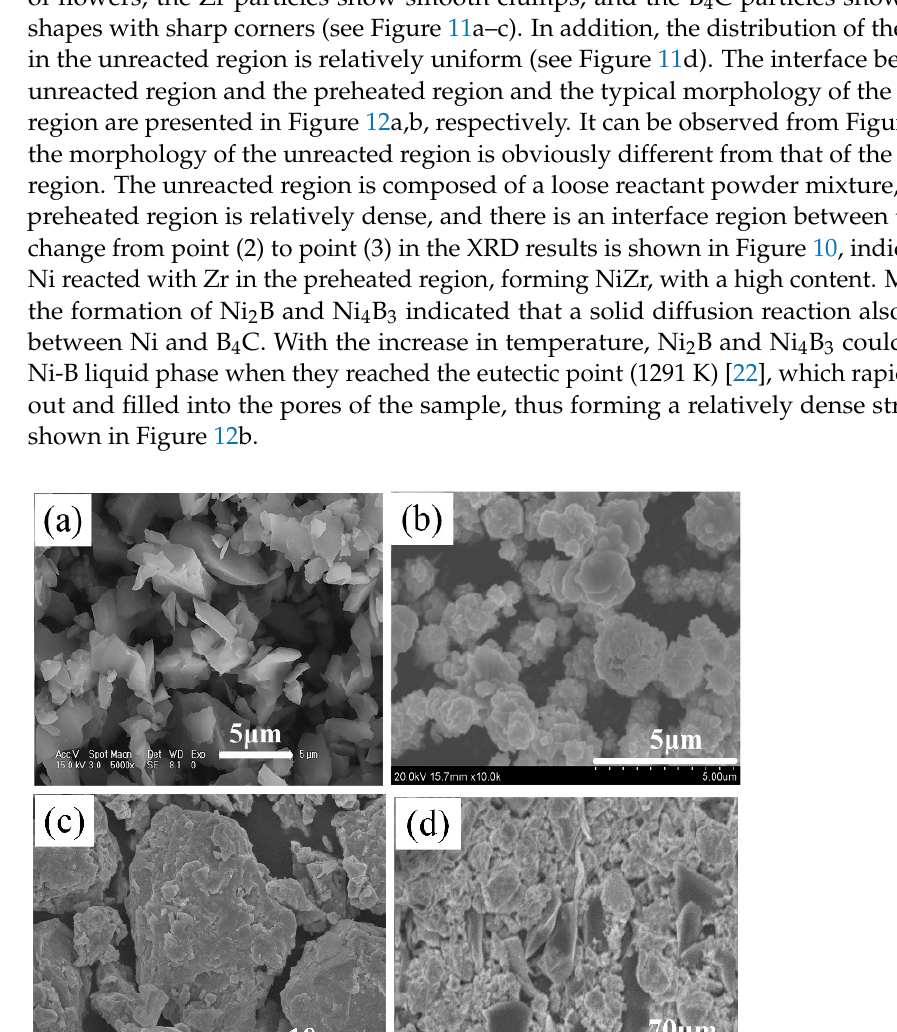
Figure 12. Microstructure of the ( a ) interface between the unreacted region and the preheated re- gion, ( b ) preheated region, ( c ) reacting region, ( d ) fully reacted region, respectively. It is worth mentioned that some papers [22] stated that TiC, rather than TiB 2 , would preferentially form in the metal-Ti-B 4 C system. However, the outcomes of this work are different, and there is no preferential formation of ZrC in the preheated region because the eutectic temperature of Ni x Zr y is much larger than that of the reported Ni x Ti y . Figure 12c exhibits the typical morphology of the reacting region. This region was more compact than the preheated region due to more liquid phase filling. It could also be observed that B 4 C was tightly surrounded by the liquid phase, and a portion of B 4 C had reacted. According to X-ray micro-diffraction and previous DSC results, the reaction be- tween Zr and B 4 C occurred first in this region, and a great quantity of exothermic heat was released. The temperature of the system increased to reach the eutectic temperature of Ni 10 Zr 7 -Ni (1423 K) and NiZr-Ni (1443 K) [23], and the Ni-Zr liquid phase was formed.